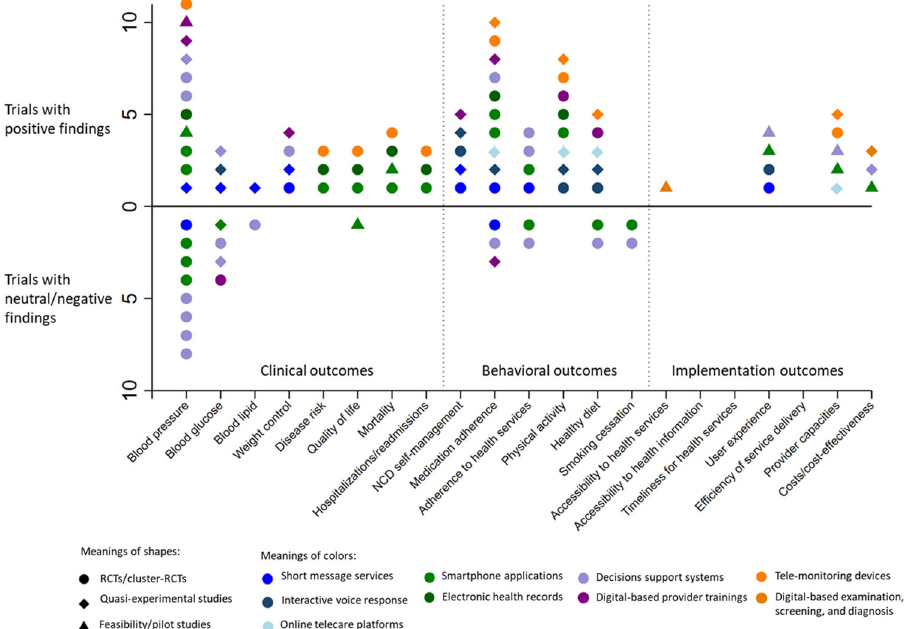
Fig. 2 The effectiveness of digital health for non-communicable disease management in primary health care in included trials. We found three major types of outcomes from all included trials, and digital health interventions ’ effectiveness varied among clinical (mixed), behavioral (positively inclined), and service implementation outcomes (clear